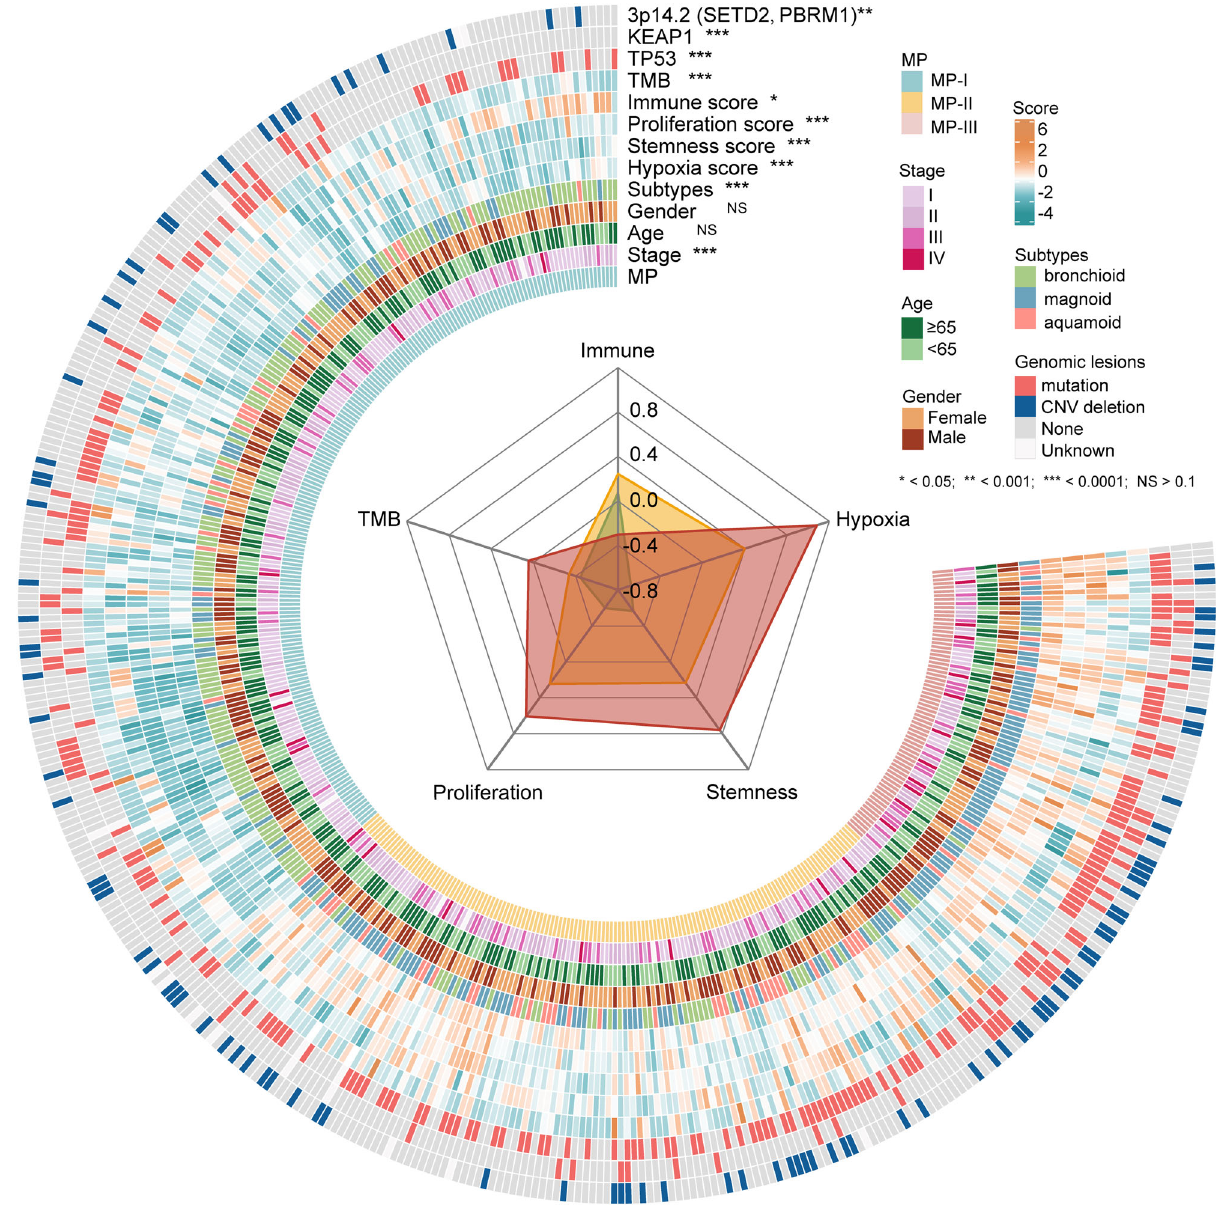
Fig. 2 Clinical and molecular characteristics of the MPs in the TCGA dataset. Circle heatmap of clinical information (stage, age, gender, transcriptomics subtypes, molecular scores, and TMB) and oncogenic events ( TP53 , KEAP1 , SETD2 , and PBRM1 ). The signi fi cance of differences ( P value) among the three MPs, estimated by Fisher ’ s exact test, is shown after each characteristic. The radar chart (inner) displays four molecular scores and TMB of the three MPs. The detailed numbers of each characteristic in the MPs are presented in Supplementary Table